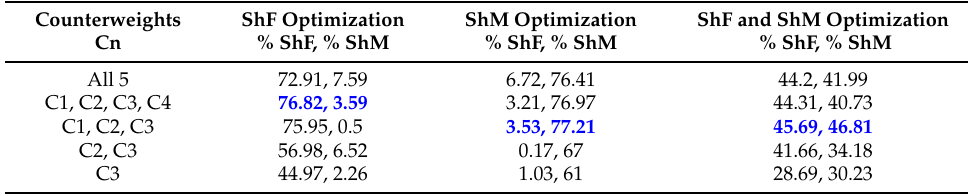
Table 3. Summary of the optimization results for the six-bar mechanism balancing. Counterweights